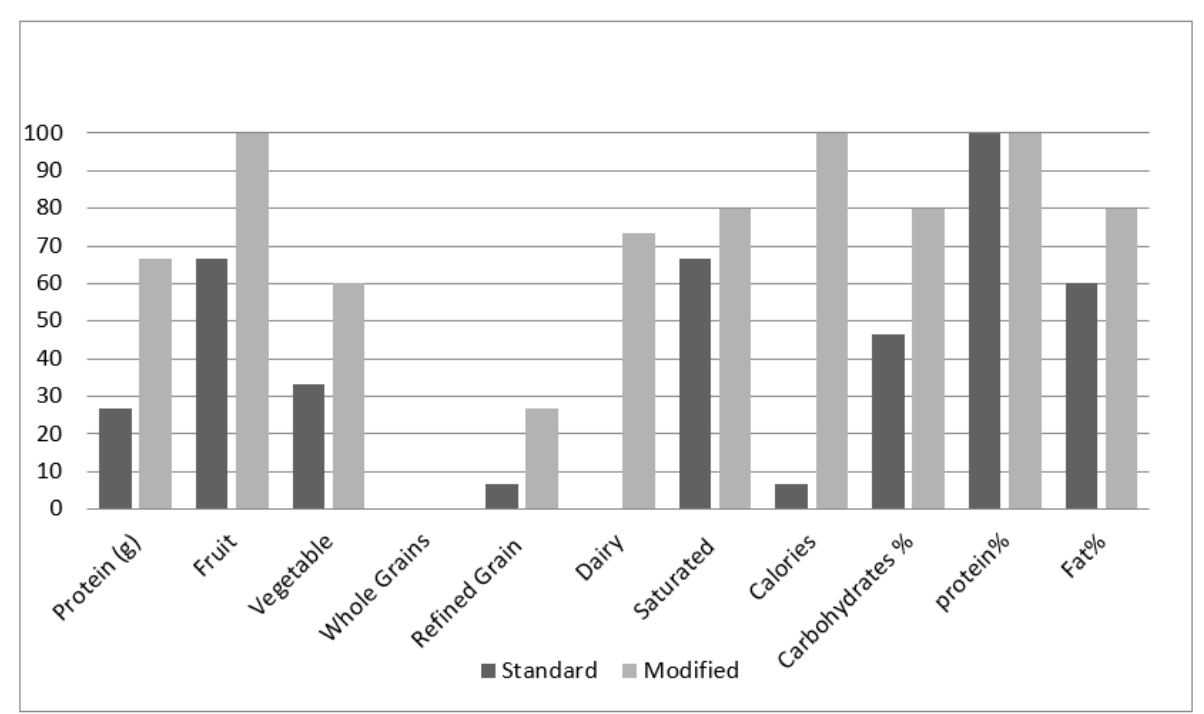
Figure 3. Number of participants in both research groups who achieved the nutritional recommen- dations in their planned diet